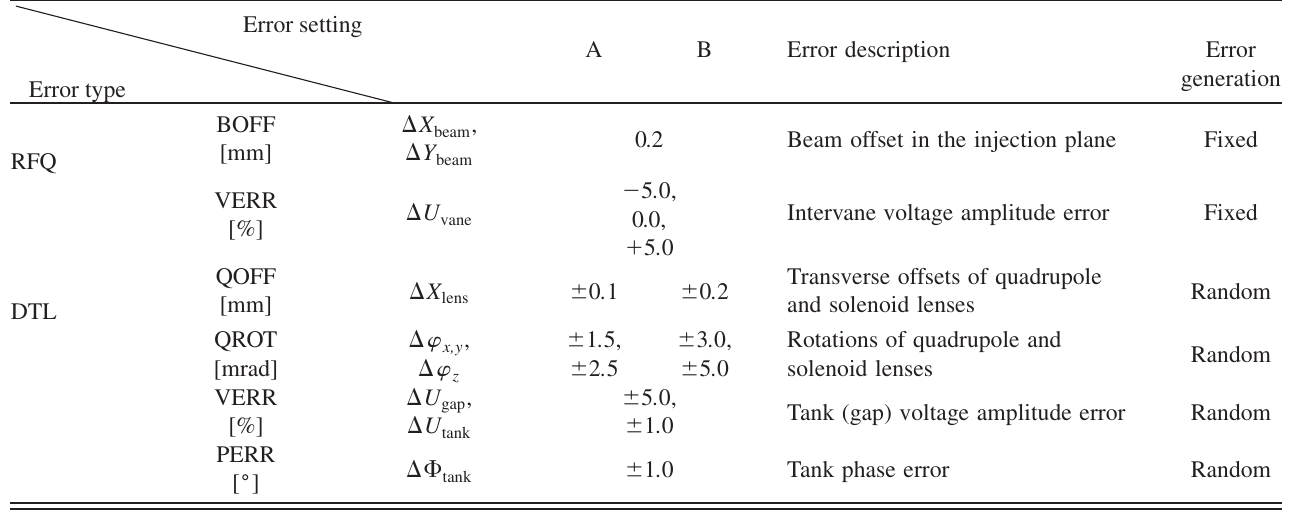
TABLE III. Error settings for the